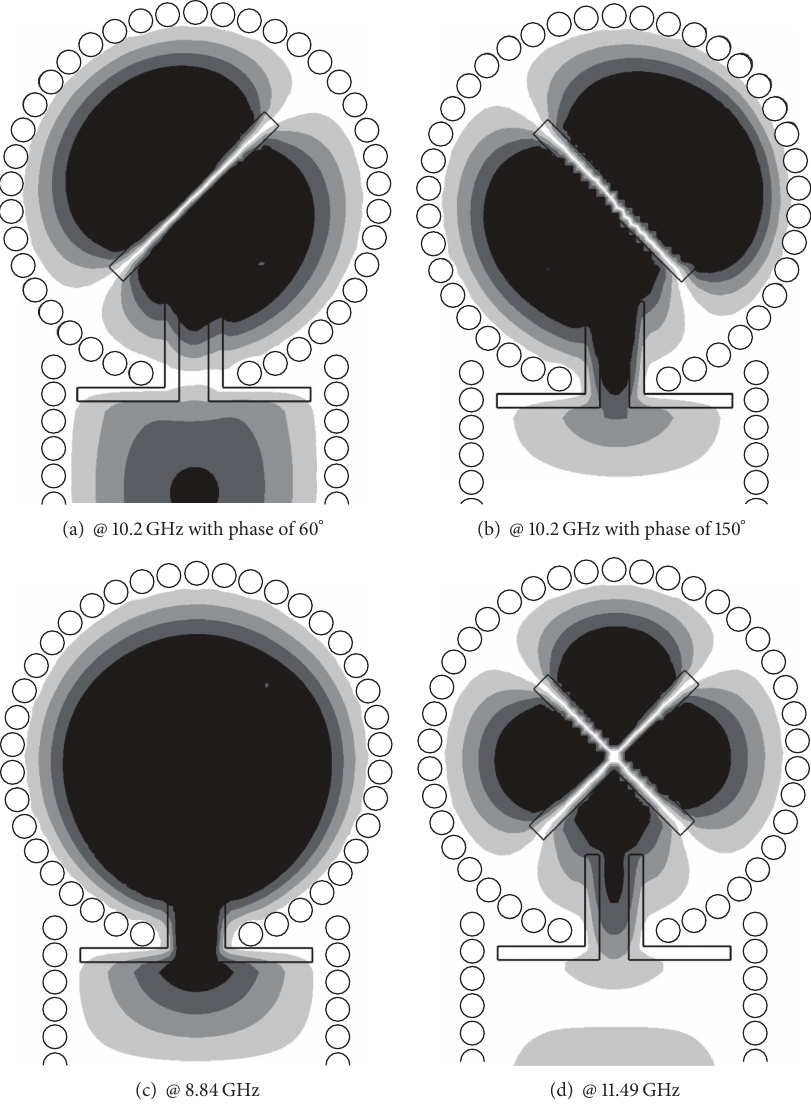
Figure 3: Electric field profiles of the proposed